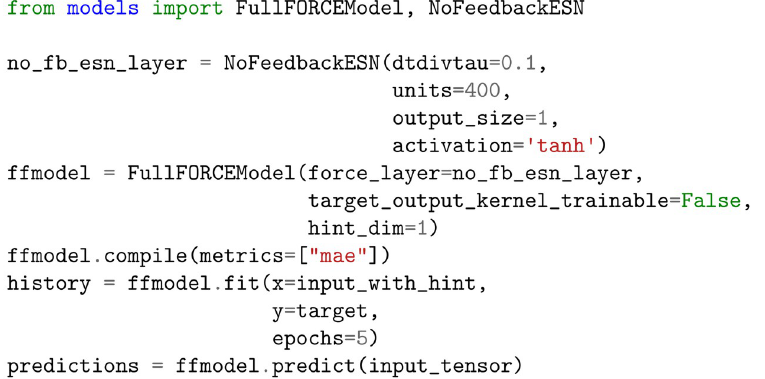
Fig 2. API for full-FORCE training of a chaotic RNN without